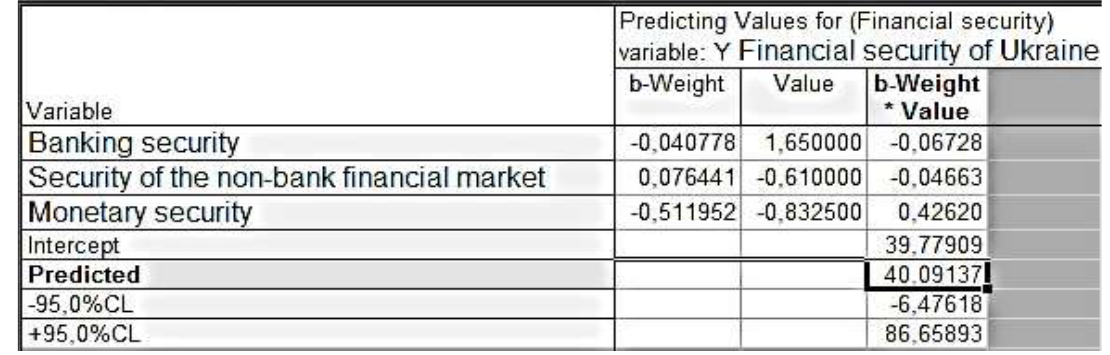
Figure 4. Results of the forecast of Ukraine’s financial security level in